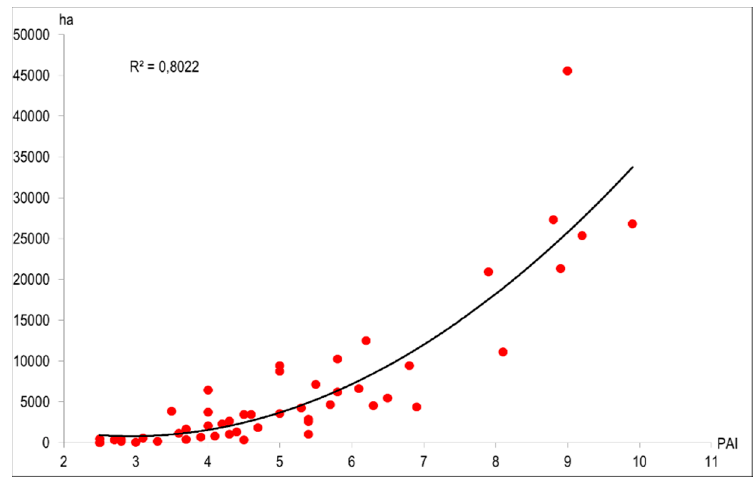
Figure 6. Correlation of the Pálfai’s drought index (PAI) and the annual forest drought damage area (ha). Source of data: Forest damage database of the Forest Research Institute; see also [32].